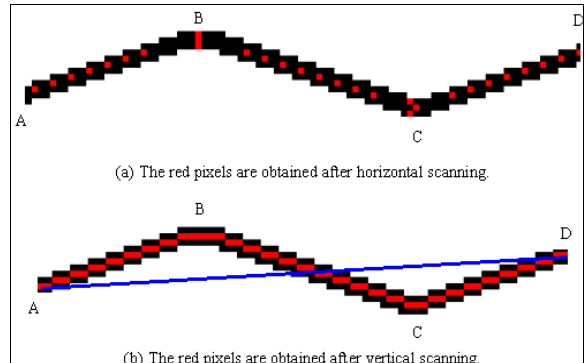
Figure 4. Detecting wrong vectorization after vertical and horizontal scanning.